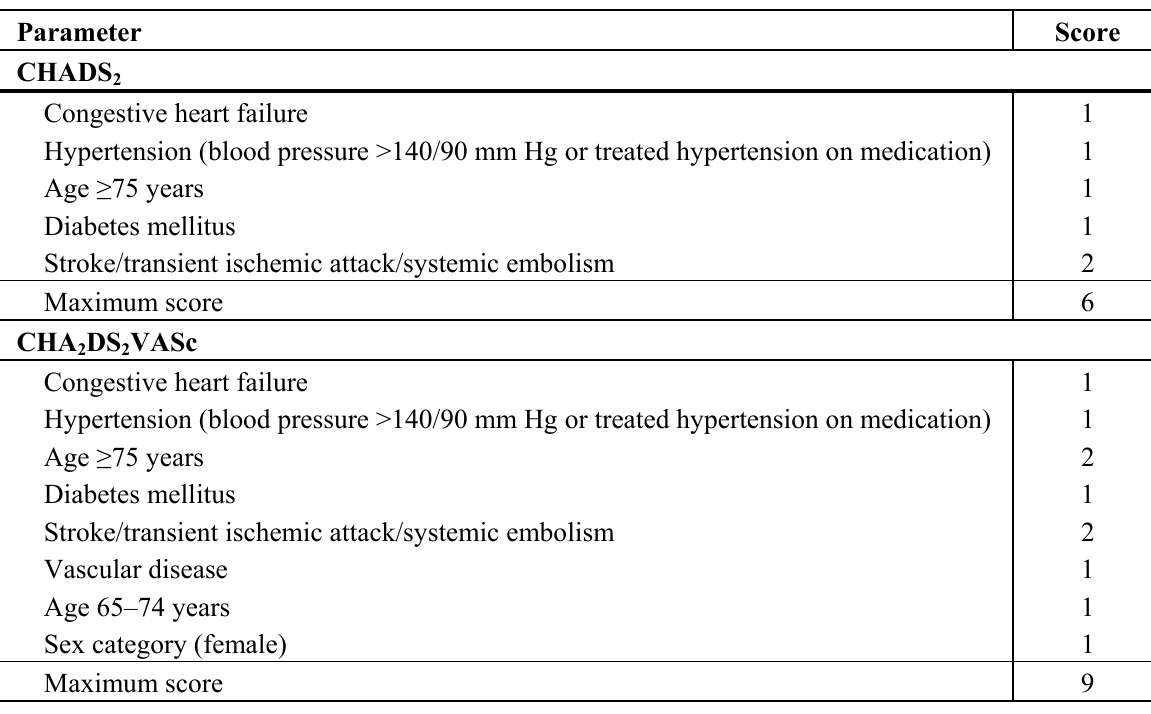
DS VASc Scores 2 2